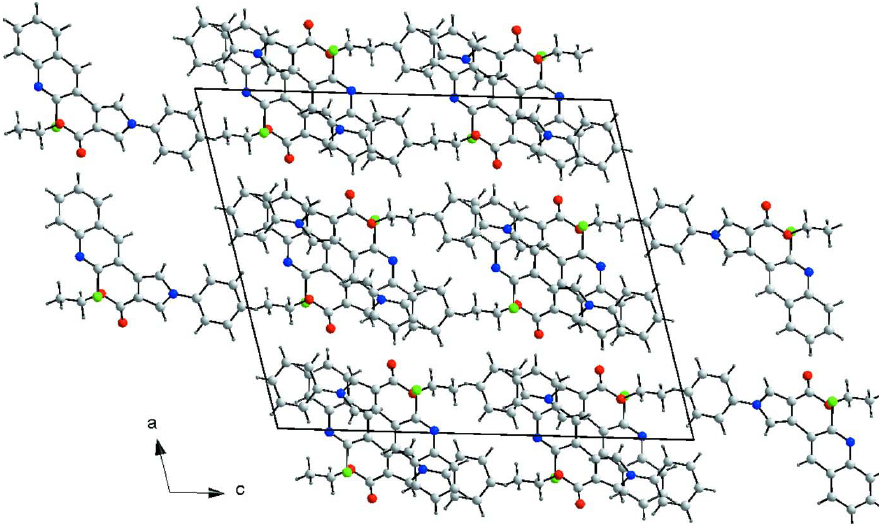
Figure 1 The molecular structure of the title compound with the atomic labelling scheme. Displacement ellipsoids are drawn at the 50% probability level.